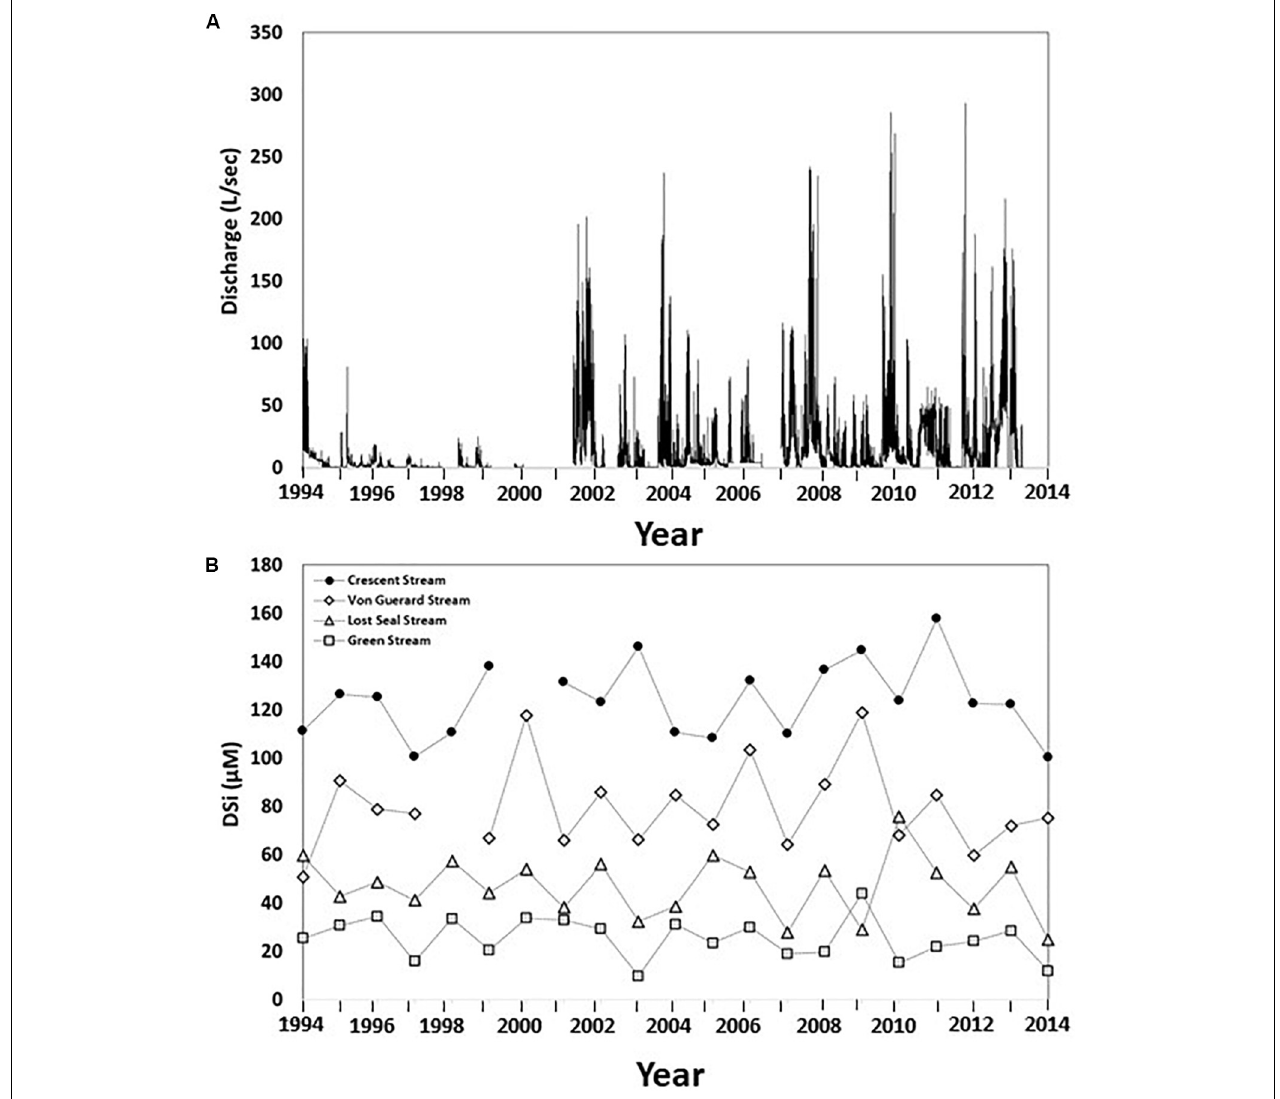
FIGURE 2 | (A) Long-term (1994–2014) discharge data at gauge F8 in Crescent Steam, from Gooseff and McKnight (2019). There are two main trends: (i) decreasing discharge during the 1990–2000, (ii) sharp increase in discharge in 2001–2002. (B) Long-term (1994–2014) dissolved silicon (DSi, < 0.4 µ m filtered water) concentrations in Crescent Stream compared with other streams in Taylor Valley, McMurdo Dry Valleys, using average concentrations for each year from Lyons and Welch (2015). Crescent Stream is one of the longest streams in Taylor Valley with elevated Si concentrations compared with other Taylor Valley